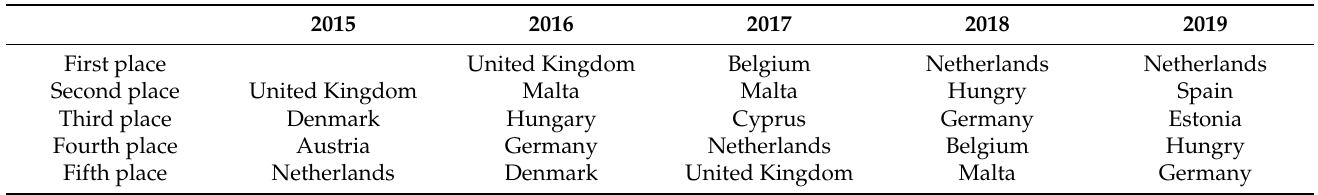
Table 9. European Union countries with maximum photovoltaic installed capacity per capita in years